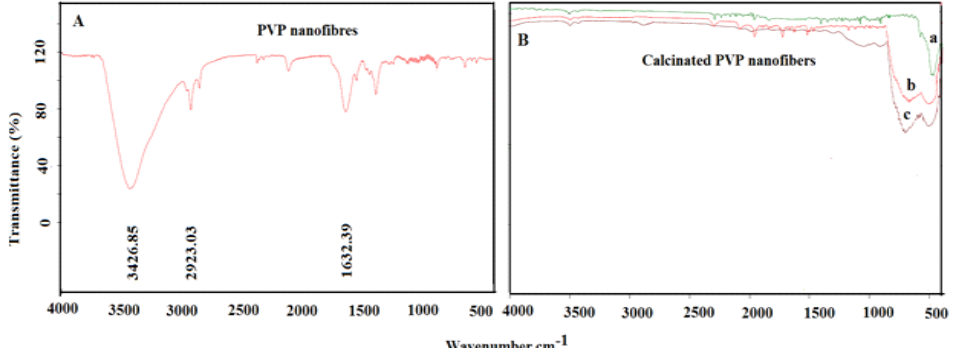
Fig. 2. FT-IR spectra of nanofibers with 50.69 wt% of TiP before (A) and after calcination (B) in different temperatures (a) 450 o C, (b) 650 o C, (c) 850 o C